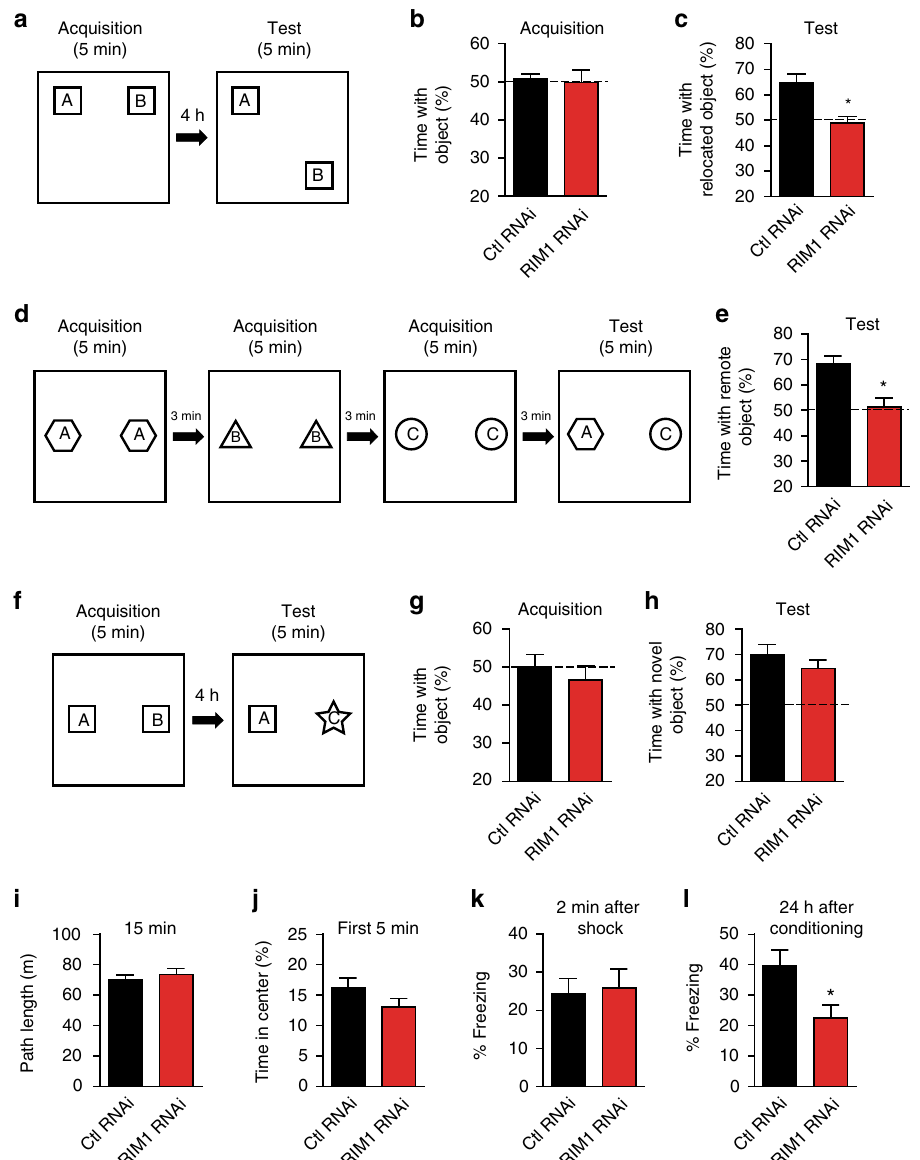
Fig. 4 RIM1 KD in the CA1 region impairs hippocampus-dependent memory. a Experimental designs for the object location task. b In the acquisition phase of the object location task, RIM1 KD and control mice spend similar time exploring the two objects; n = 10 mice/group, t -test, p > 0.05. c In the test phase of the object location task, RIM1 KD mice fail to show preference for the relocated object; n = 10 mice/group, t -test, * p < 0.05. d Experimental design for the temporal order memory task. e In the temporal order memory task, control mice prefer the object explored early to that explored last, whereas mice with RIM1 KD have impaired performance in this task; n = 10 mice/group, t -test, * p < 0.05. f Experimental design for the novel object preference task. In both the acquisition phase ( g ) and the test phase ( h ) of the novel object preference task, RIM1 KD and control mice spend similar time exploring the two objects; n = 10 mice/group, t -test, p = 0.34. i In the open fi eld test, RIM1 KD and control mice show similar locomotor activity during 15 min of open fi eld exploration; n = 10 mice/group, t -test, p > 0.05. j RIM1 KD mice and control mice spend similar time in the center of the open area during the fi rst 5 min of exploration; n = 10 mice/group, t -test, p > 0.05. k In contextual fear conditioning, there is no signi fi cant difference between RIM1 KD and control mice in freezing responses during the last 2 min of training; n = 10 mice/group, t -test, p > 0.05. l Twenty-four hours after conditioning, RIM1 KD mice show a signi fi cant reduction in the time spent freezing; n = 10 mice/group. Bar graphs and individual points represent the mean ± s.e.m.; t -test, * p < 0.05 explored the novel object more frequently than the known one in spent in the center of the open arena during the fi rst 5 min of the retrieval phase, indicating normal perirhinal cortex- exploration (control RNAi, 16.2 ± 1.6%, n = 10 mice; RIM1 dependent memory (control RNAi, 78.4 ± 5.0%, n = 10 mice; RNAi, 13.1 ± 1.3%, n = 10 mice; p = 0.15; Fig. 4j). Together, these RIM1 RNAi, 71.3 ± 5.1%, n = 10 mice; p = 0.34; Fig. 4g, h). In results suggest that RIM1 in the CA1 region is required for addition, RIM1 KD did not evoke noticeable changes in loco- motion (control RNAi, 23.4 ± 0.9 m, n = 10 mice; RIM1 RNAi, 24.5 ± 1.3 m, n = 10 mice; p > 0.05; Fig. 4i), and had only weak effects that did not reach a 0.05 level of signi fi cance on the time | DOI: 10.1038/s41467-018-04672-0 |